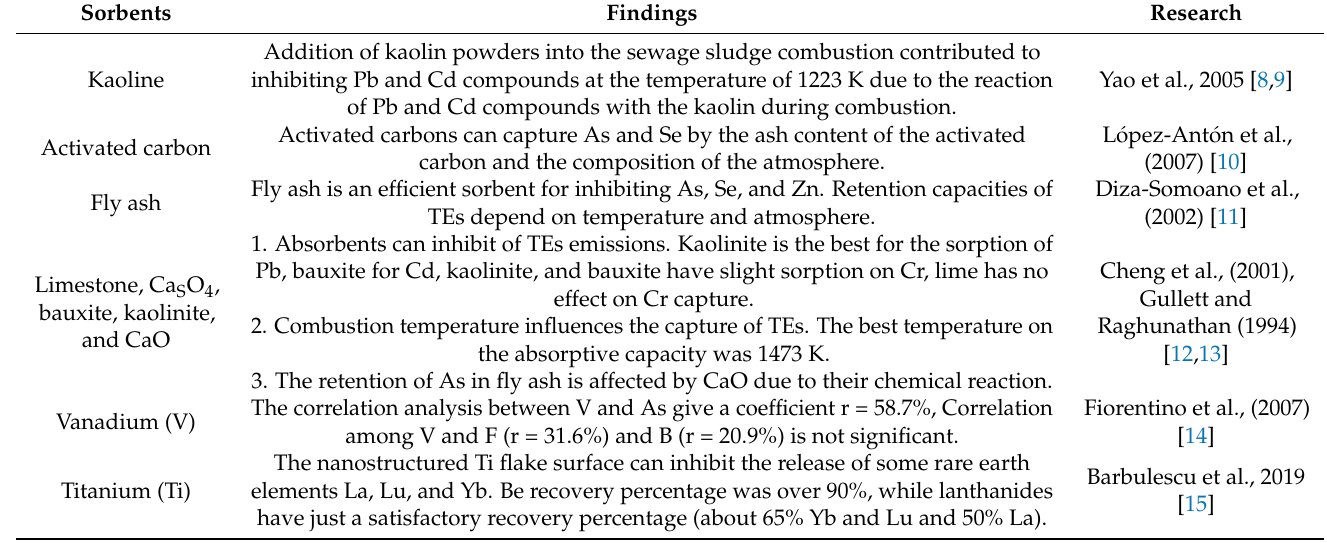
Table 1. Literature on the ability of sorbents to inhibit the release of volatilized